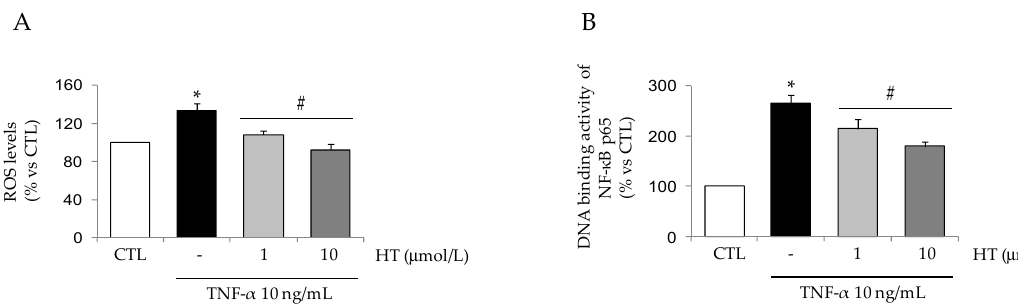
Figure 8. Attenuation by HT of TNF- α -induced ROS production and NF- κ B activation. SGBS cells were treated with 1 and 10 µ mol / L HT and then stimulated with 10 ng / mL TNF- α for 1 h. ( A ) Intracellular levels of ROS were monitored by using the redox sensitive fluorescent probe carboxy-H2DCFDA, and expressed as percent of unstimulated control (CTL). ( B ) Nuclear proteins were analyzed for NF- κ B p65 DNA-binding activity by ELISA as described in Methods. Data are expressed as percent of untreated control (CTL). Bars represent means ± SD ( n = 3). * p < 0.05 vs. CTL. # p < 0.05 vs. TNF- α .